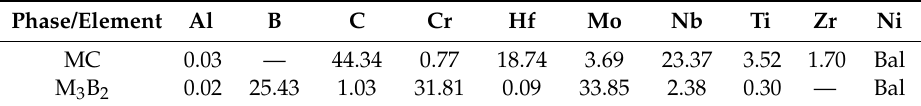
Table 3. Chemical compositions in at. % of the solidified phases as displayed in Figure 4.